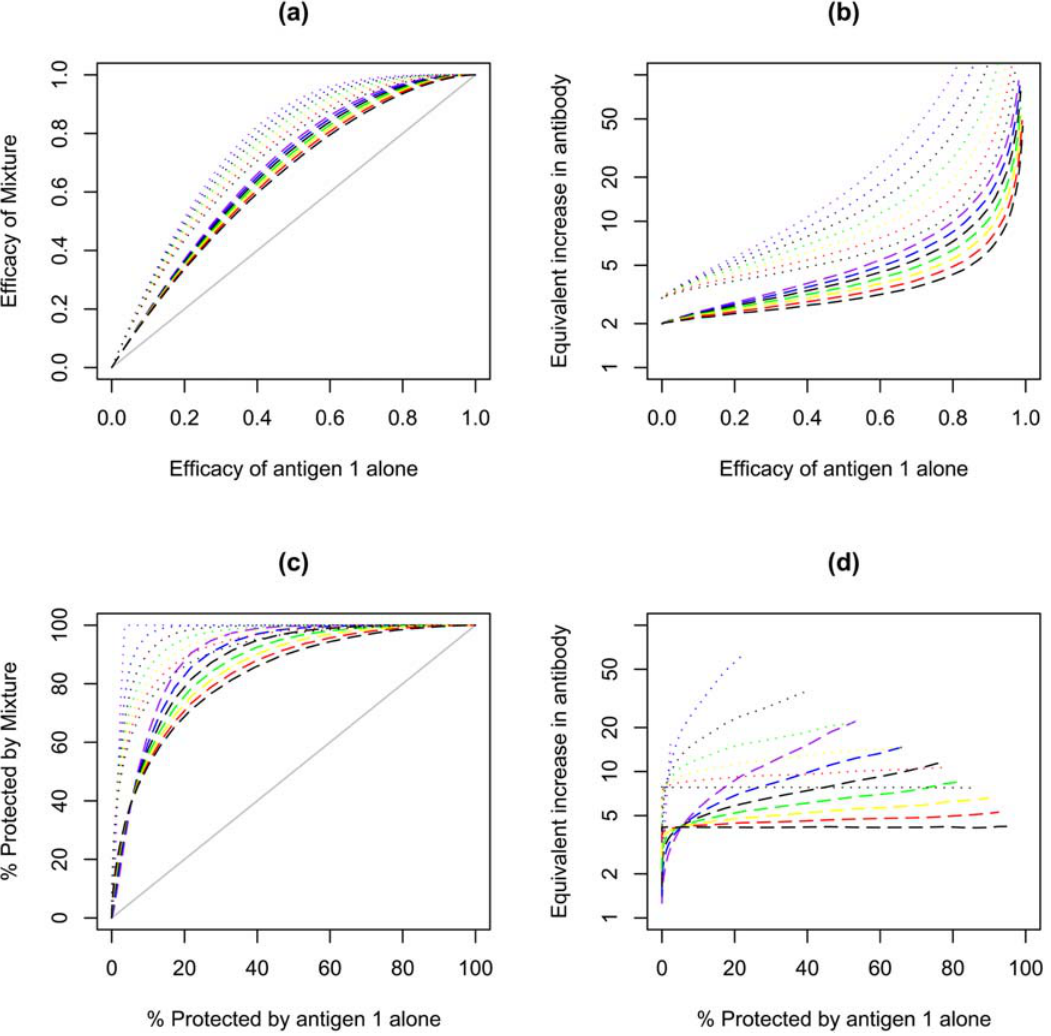
Figure 5. Effect of the correlation of immune responses to the immunogens in a two component (dashed lines) or three component (dotted lines) vaccine on efficacy and the percent population protected. Model assumes that the diversity of the immune response generated by each component is similar (fold range is 65 fold) and that the level of the immune response to the individual components is similar. Immune responses have a correlation coefficient (r) of 1 (lower black line), 0.75 (red), 0.5 (yellow), 0.25 (green), 0 (upper black), 2 0.25 (blue) and 2 0.5 (purple). Other details are described in the Figure 3 legend.